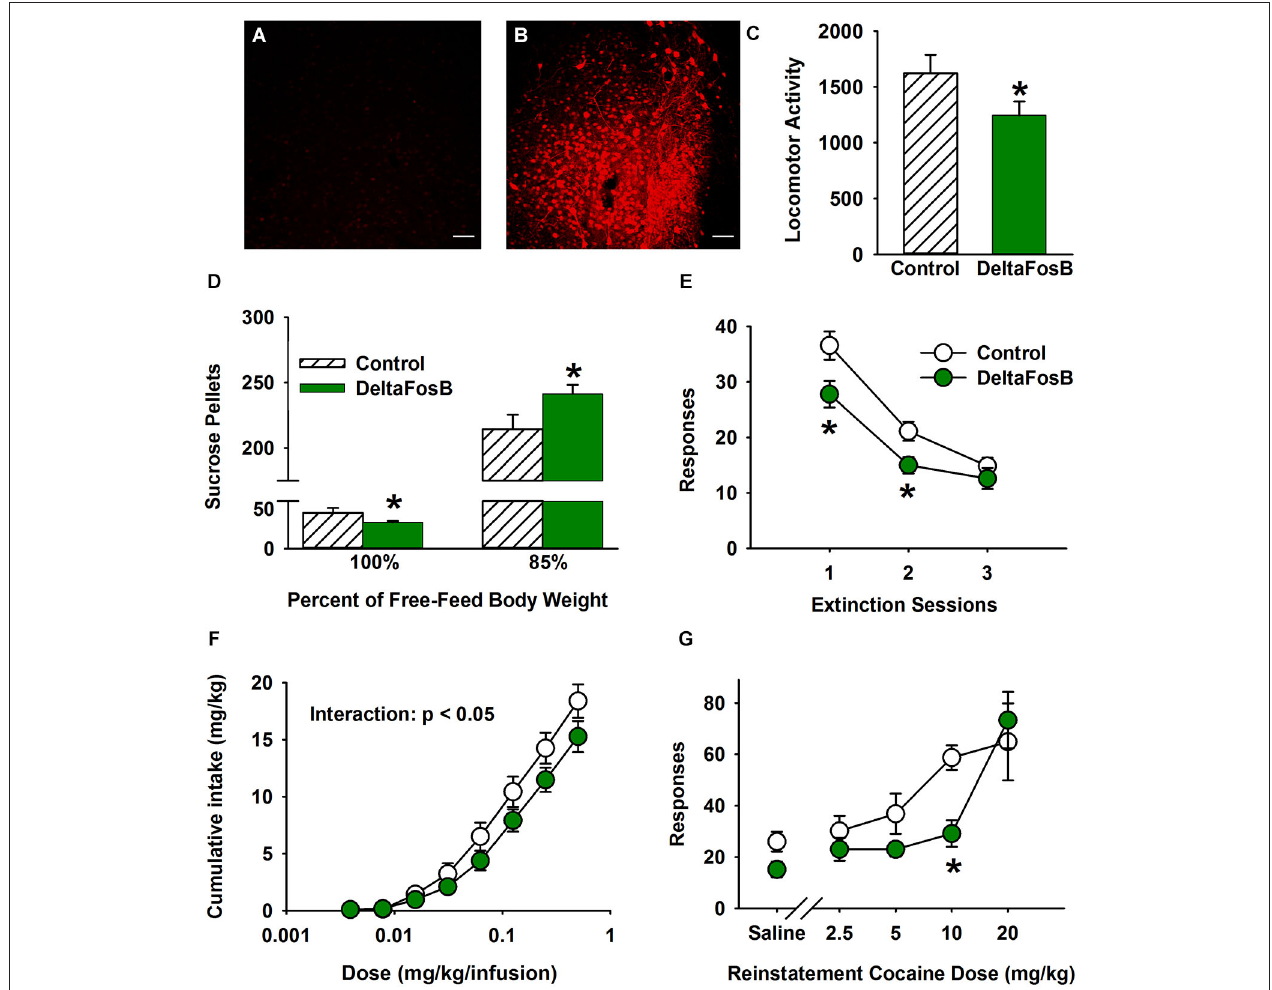
conditions (100% free feed weight). (E) Effect of overexpression of ∆ FosB on extinction of cocaine self-administration. (F) Effects of overexpression of ∆ FosB on cumulative cocaine self-administration: FR dose response function. (G) Overexpression of ∆ FosB significantly decreased the reinstatement response to cocaine injections. N = 6–10 for all behavior experiments. Asterisks (*) denote differential responding from control vector